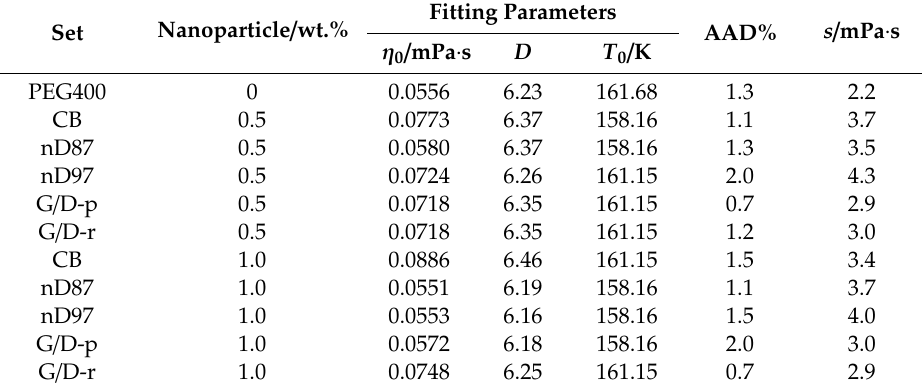
Table 4. Fitting parameters ( η 0 , D , T 0 ), absolute average deviations ( AAD% ) and standard deviation ( s ) obtained from the Vogel-Fulcher-Tammann-Hesse model, Equation (3), when modelling the temperature dependence of shear viscosity obtained at ~100 s − 1 for neat PEG400 and carbon-based PEG400 dispersions. Set